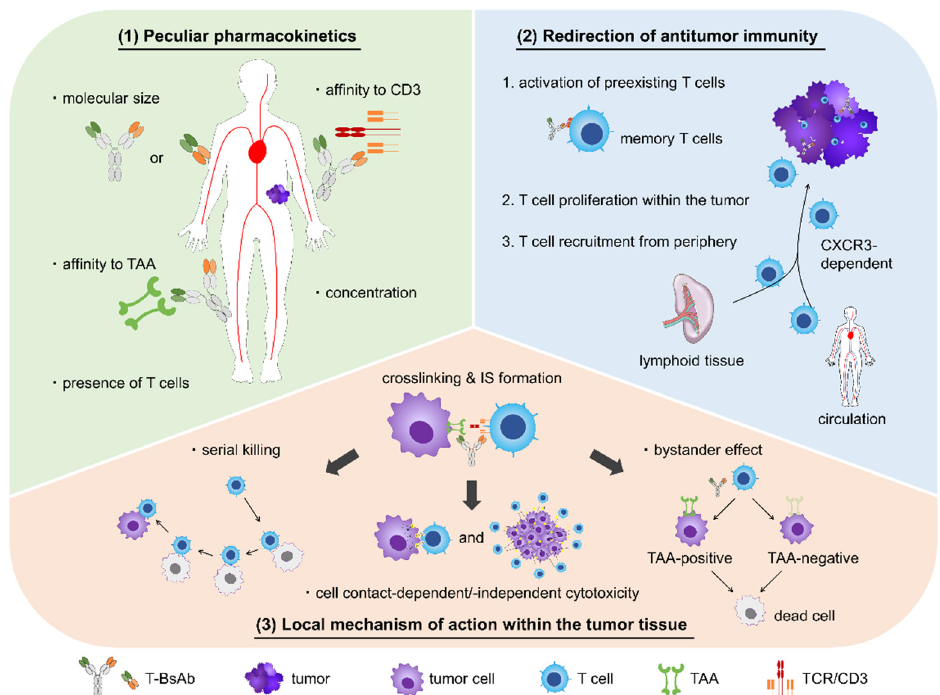
Figure 1. Three pharmacological properties of T-BsAbs. (1) T-BsAbs are characterized by their unique pharmacokinetics, derived from the dual binding affinity to molecules on tumor cells (tumor-associated antigens (TAA)) and T cells (CD3). As with conventional antibody therapeutics, T-BsAbs have absorption, distribution, metabolism, and excretion characteristics that are dependent on their molecular size and concentration. Furthermore, their delivery to the tumor lesion is affected by their binding affinity to not only TAA but also CD3. Within the tumor tissue, T-BsAbs are distributed partly according to the presence and location of infiltrating T cells. (2) T-BsAbs promote antitumor immunity within the tumor tissue. First, memory T cells, which are mixture of central memory and effector memory phenotypes and preexist in the tumor, are cross-linked to tumor cells by tumor-accumulated T-BsAbs, thus initiating T cell activation. Activated T cells then proliferate in response to intracellular signaling and secrete proinflammatory cytokines. Subsequently, peripheral T cells are recruited to the tumor from the circulation and secondary lymphoid tissues in a CXCR3-dependent manner. (3) Once T cells are crosslinked with tumor cells via T-BsAbs, immune synapses (ISs) are formed between pairs of cells, and activated T cells lyse the bridged tumor cells using perforin and granzyme. Active T cells continue to kill neighboring tumor cells by repeated cell contact. Moreover, T-BsAb-activated T cells release cytotoxic and proinflammatory cytokines, resulting in cell contact-independent cell killing and the FasL-mediated bystander effect, respec- tively.